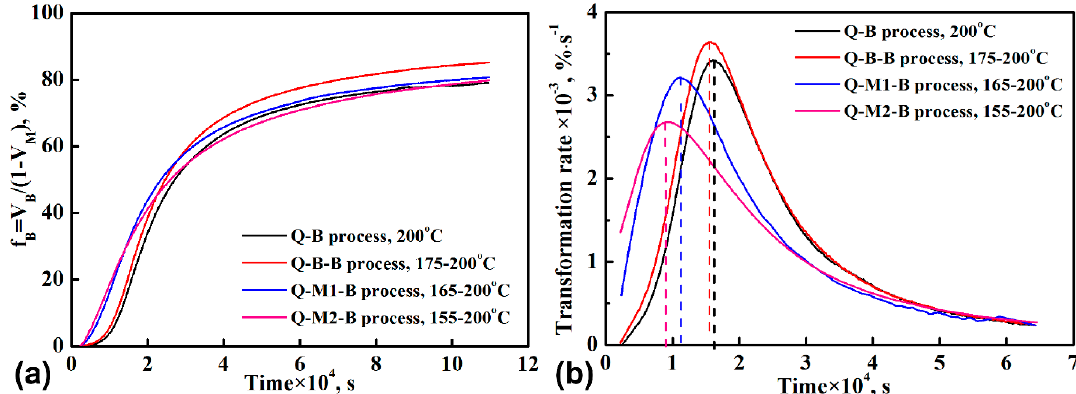
Figure 5. ( a ) Variation of volume fraction of bainitic ferrite with holding time and ( b ) the variation of transformation rate with holding time.